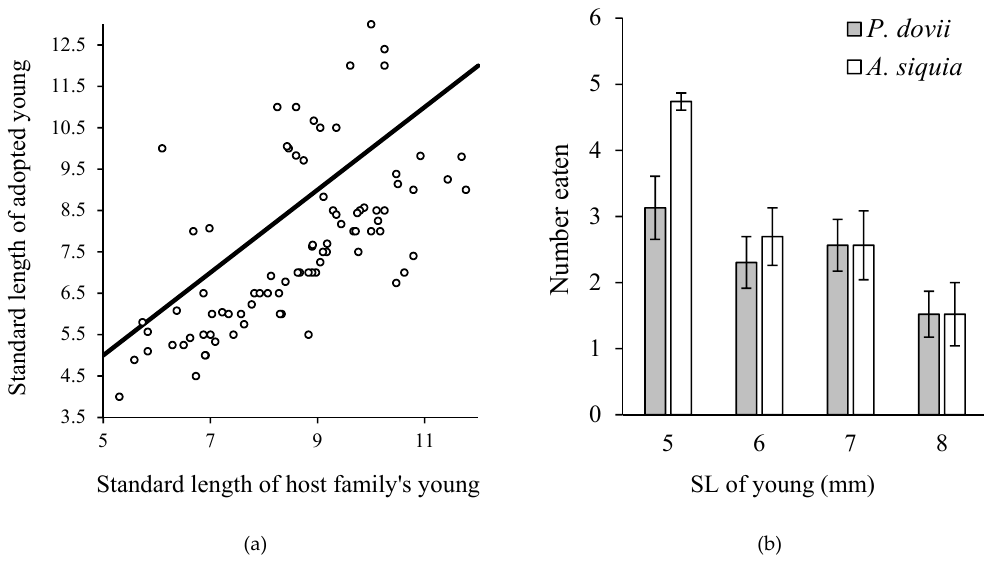
Figure 9. ( a ) Size-biased conspecific adoption of broods from neighboring families. Line is y = x. When young are adopted from neighboring families, parents accept young that are smaller than their own and reject those that are larger than their own (data not shown), until the host young are larger than 8 mm SL. This raised the possibility that adopted young are being set up as targets for predators to spare predation on host young, which was confirmed in a subsequent field experiment. ( b ) Hunting success of juvenile convict cichlids and juvenile P. dovii on groups of convict cichlid fry of mixed sizes. Small fry were eaten significantly more often than large fry. Data from [18].